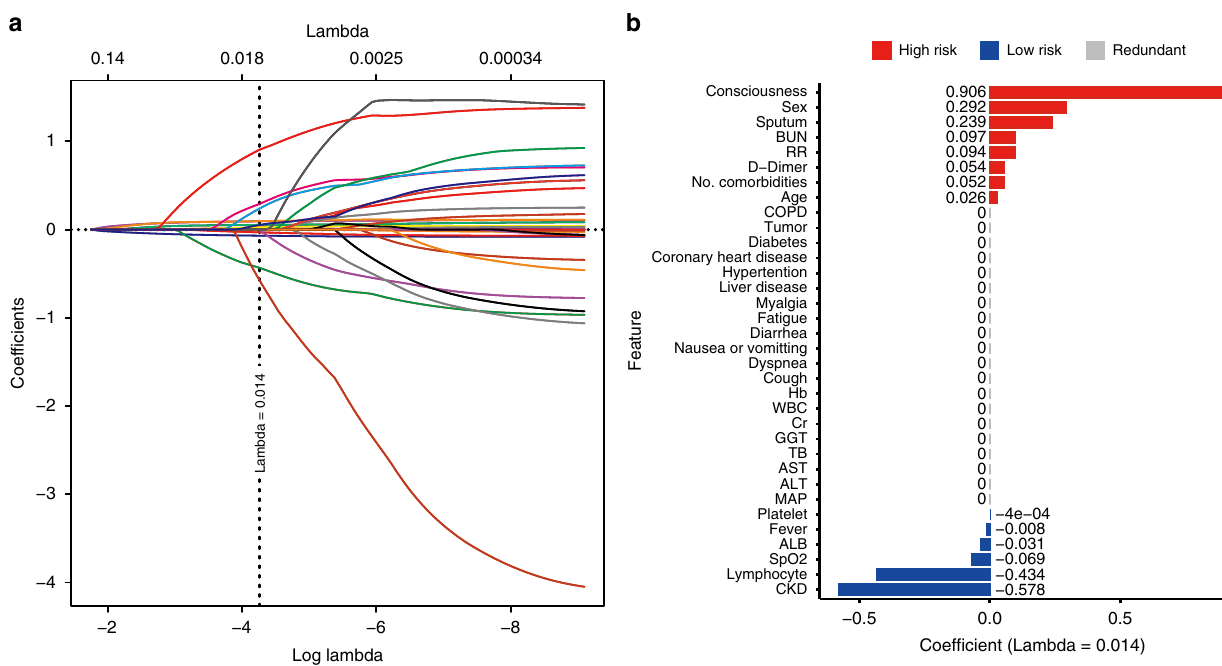
Fig. 2 Feature selection by LASSO. a LASSO variable trace pro fi les of the 34 features whose intracohort missing rates were less than 5%. The vertical dashed line shows the best lambda value 0.014 chosen by tenfold cross validation. b Feature coef fi cient of LASSO with best lambda value 0.014. High-risk (positive coef fi cient) and low-risk (negative coef fi cient) features are colored in red and blue, respectively. Gray features with coef fi cient 0 were considered redundant and removed, resulting in 14 features left for downstream prognosis modeling. LASSO least absolute shrinkage and selection operator, BUN blood urea nitrogen, RR respiratory rate, COPD chronic obstructive pulmonary disease, Hb hemoglobin, WB, white blood cell count, Cr creatinine, GGT gamma-glutamyl transferase, TB total bilirubin, AST aspartate aminotransferase, ALT alanine transaminase, MAP mean arterial pressure, ALB albumin, SpO 2 oxygen saturation, CKD chronic kidney